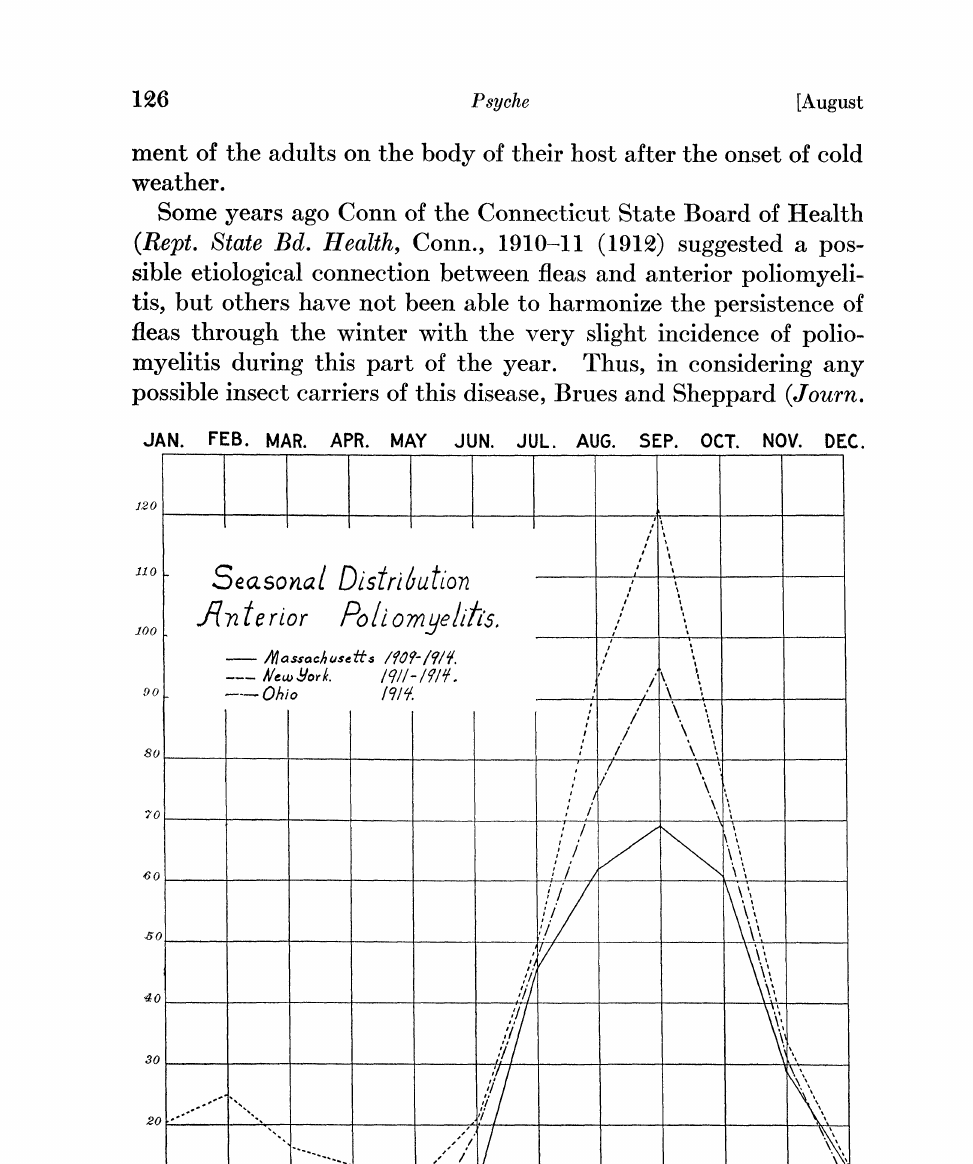
Table 1. Seasonal Incidence of Anterior Poliomyelitis in Massachusetts, New York and